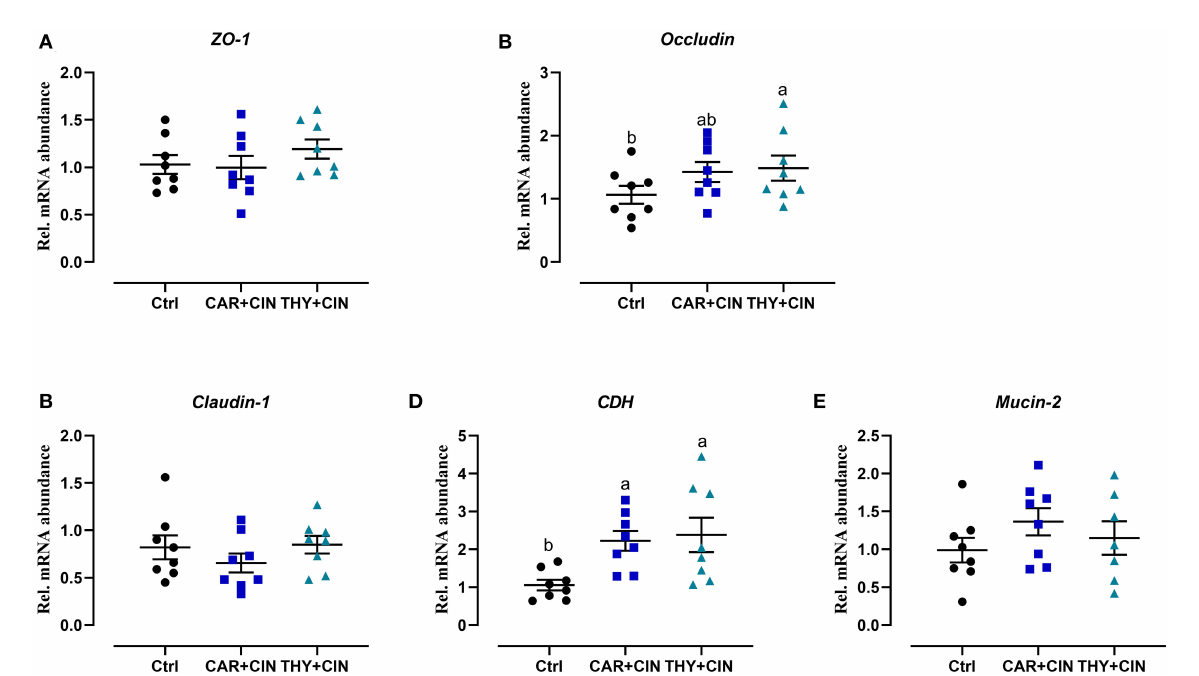
FIGURE3 The effect of dietary cinnamaldehyde with carvacrol (CAR + CIN) or thymol (THY + CIN) essential oils on mRNA levels related to the intestinal barrier in mid-duodenum of post-peak laying hens. Tight junction protein including (A) Zonula occludens-1 (ZO-1) . (B) Occludin . (C) Claudin-1 . (D) Cadherin ( CDH ). (E) Mucin-2 mRNA abundance. Values are mean ± standard error in scatter plot ( n = 8). Means without a common letter are significantly different ( P < 0.05). In this study, a total of 384, 50-week-old Hy-line brown laying hens were randomly divided into a basal diet (Ctrl), a basal diet with 100 mg/kg of essential oils consisting of 4.5% of cinnamaldehyde with 13.5% of carvacrol (CAR + CIN), and a basal diet containing 100 mg/kg of essential oils composed of 4.5% of cinnamaldehyde with 13.5% of thymol (THY + CIN) for 6